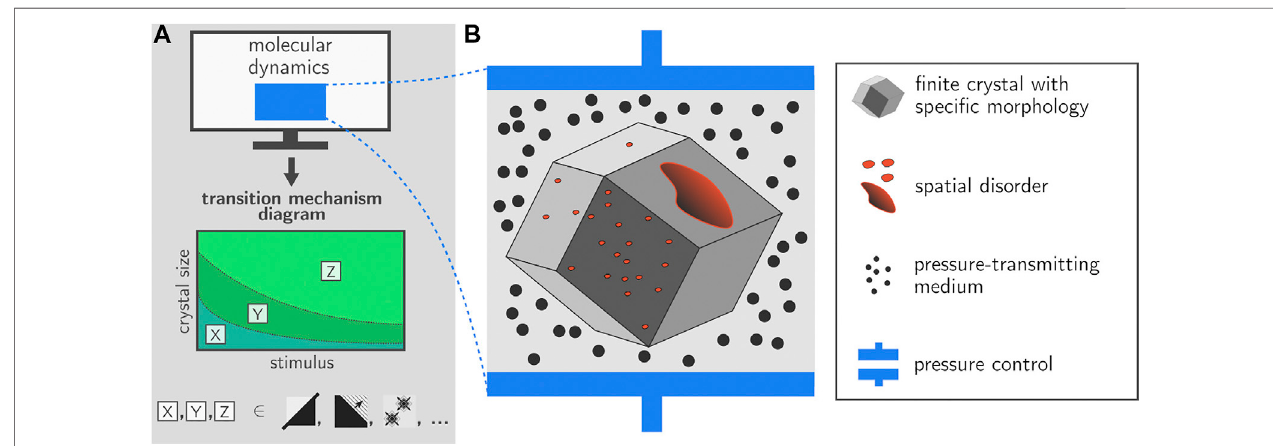
FIGURE6| Futureresearchontransitiondynamicswithinframeworkmaterialsshouldtakeintoaccountthe fi nitecrystalsize,variousformsofspatialdisorder,and the external surface. It should become possible to provide transition mechanism diagrams which illustrate which transition mechanisms are preferred as a function of control variables such as crystal size and external stimulus (e.g., fully cooperative, layer-by-layer, discrete nucleation points).